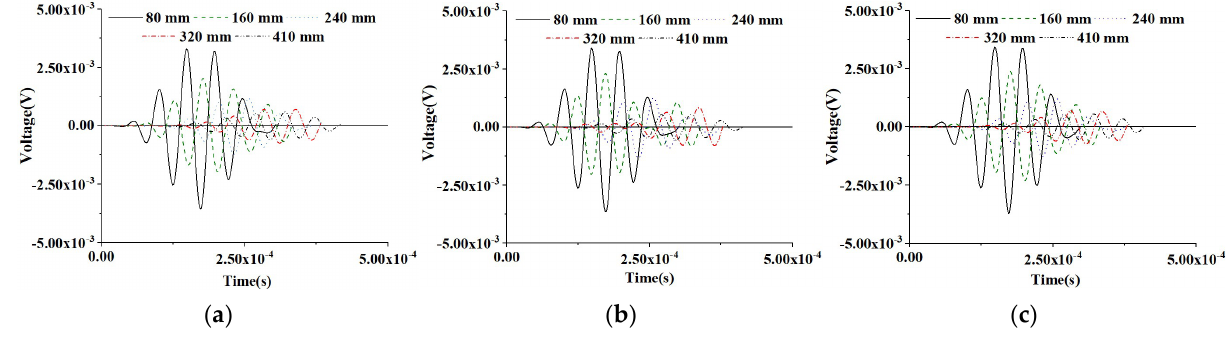
Figure 9. Output voltage collected by sensors at different measurement distances from the actuator under a modulated sinusoidal excitation signal for CMFEMs with an interface debond defect. ( a ) CMFEM 1D; ( b ) CMFEM 2D; ( c ) CMFEM 3D.